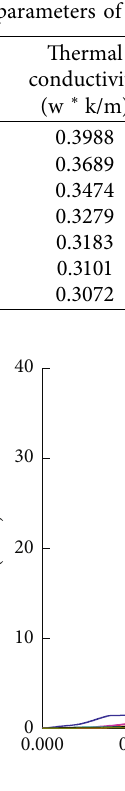
Figure 3: Compressive strength stress-strain